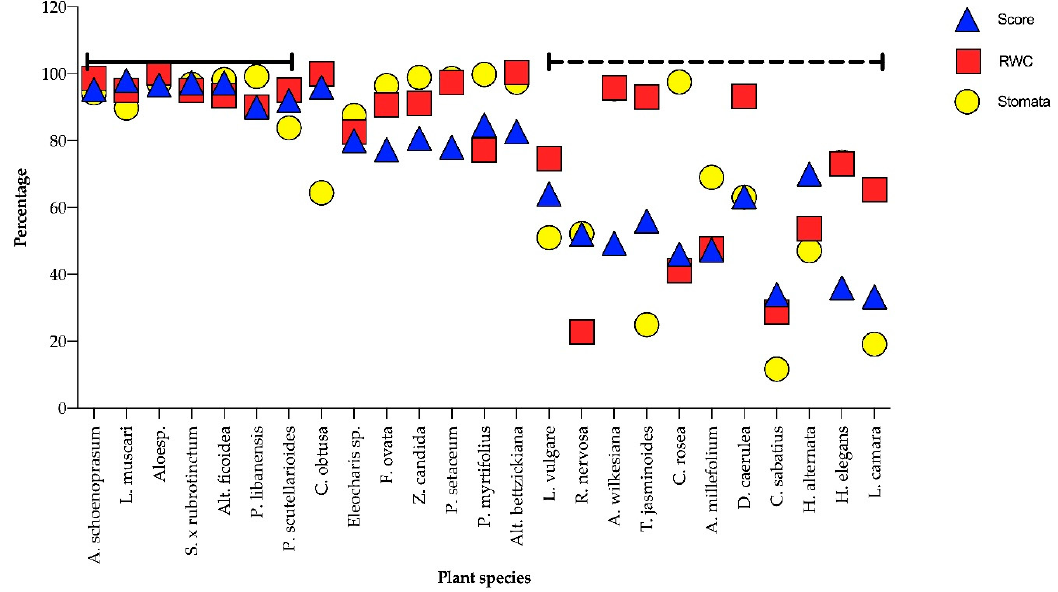
Figure 7. Classification of 25 ground cover species using 3 prameters (leaf relative water content: red, relative index of aesthethic appeal: blue, and percent stomata opening: yellow) for drought tolerant (solid line) and drought sensitive (dotted line) groups.